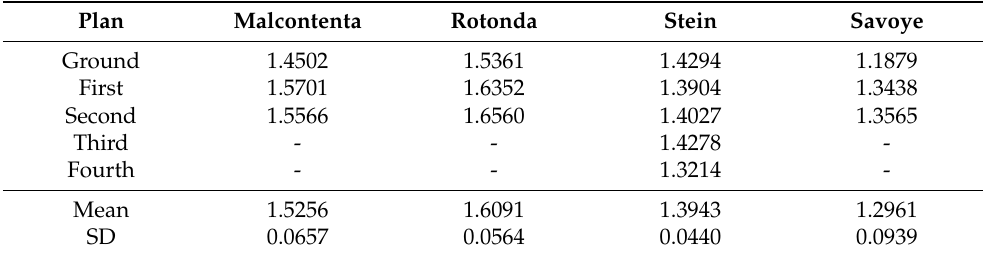
Table 2. D values of floor plans.